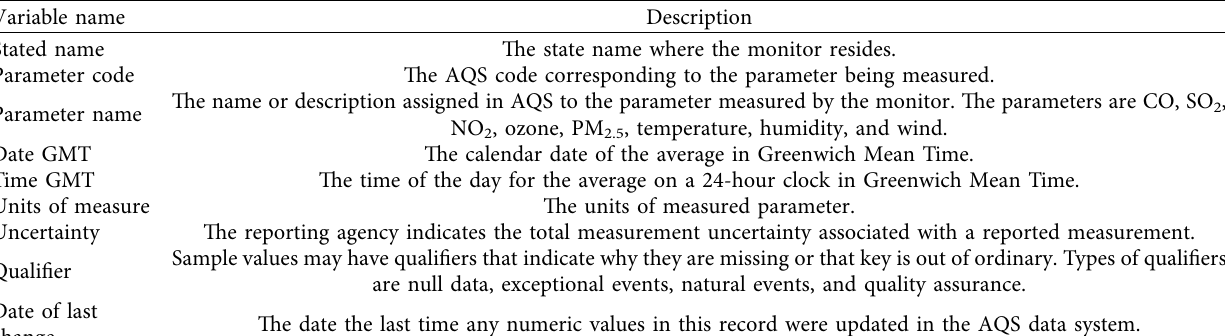
Table 2: Dataset variable description.